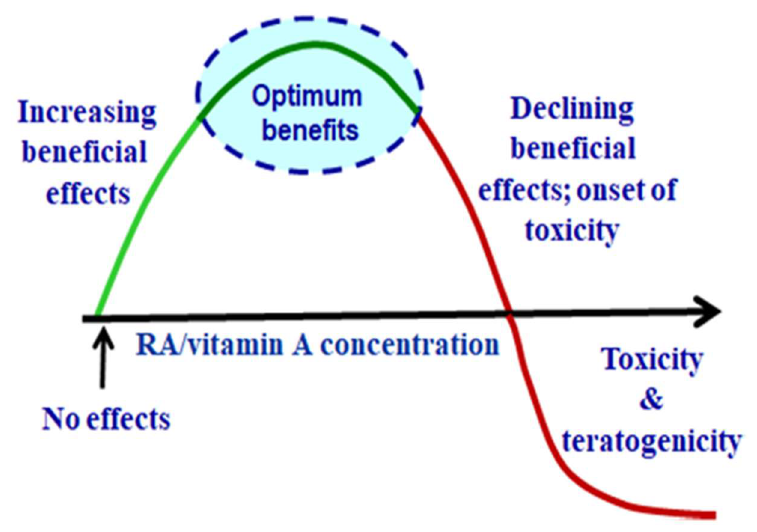
Figure 3. Vitamin A and RA exhibit hormesis . Retinoids display qualitative dose–response ef- fects.